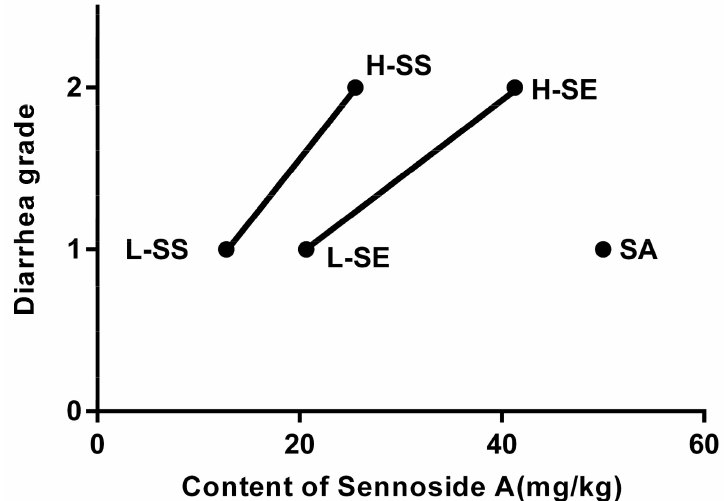
Figure 1. The diarrhea grade in the rats treated with a low dose of senna extract (L-SE), high dose of senna extract (H-SE), low dose of sennosides (L-SS), high dose of sennosides (H-SS), and sennoside A (SA) for over six days. The horizontal axis represents the content of sennoside A in each administration. The vertical axis depicts the diarrhea grade (1, 2 refers to loose stool and watery diarrhea, respectively). 2.2. The Body Weight Lost in the Diarrhea-Rats Induced by the SE But Not by the SS and